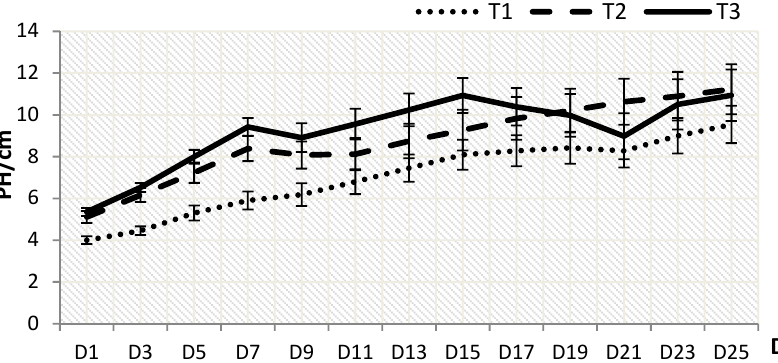
Figure 1. Effect of shading levels on plant height, PH (Data are means of treatments, N = 96; Rep = 4; Control, T1 = 0% Shaded; T2 = 50% Shading and T3 = 70% Shading; Small bars represent standard error).